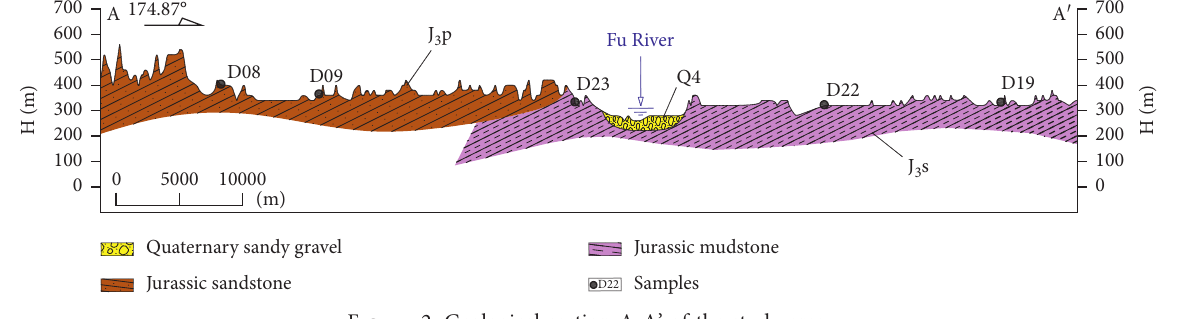
Figure 2: Geological section A-A’ of the study